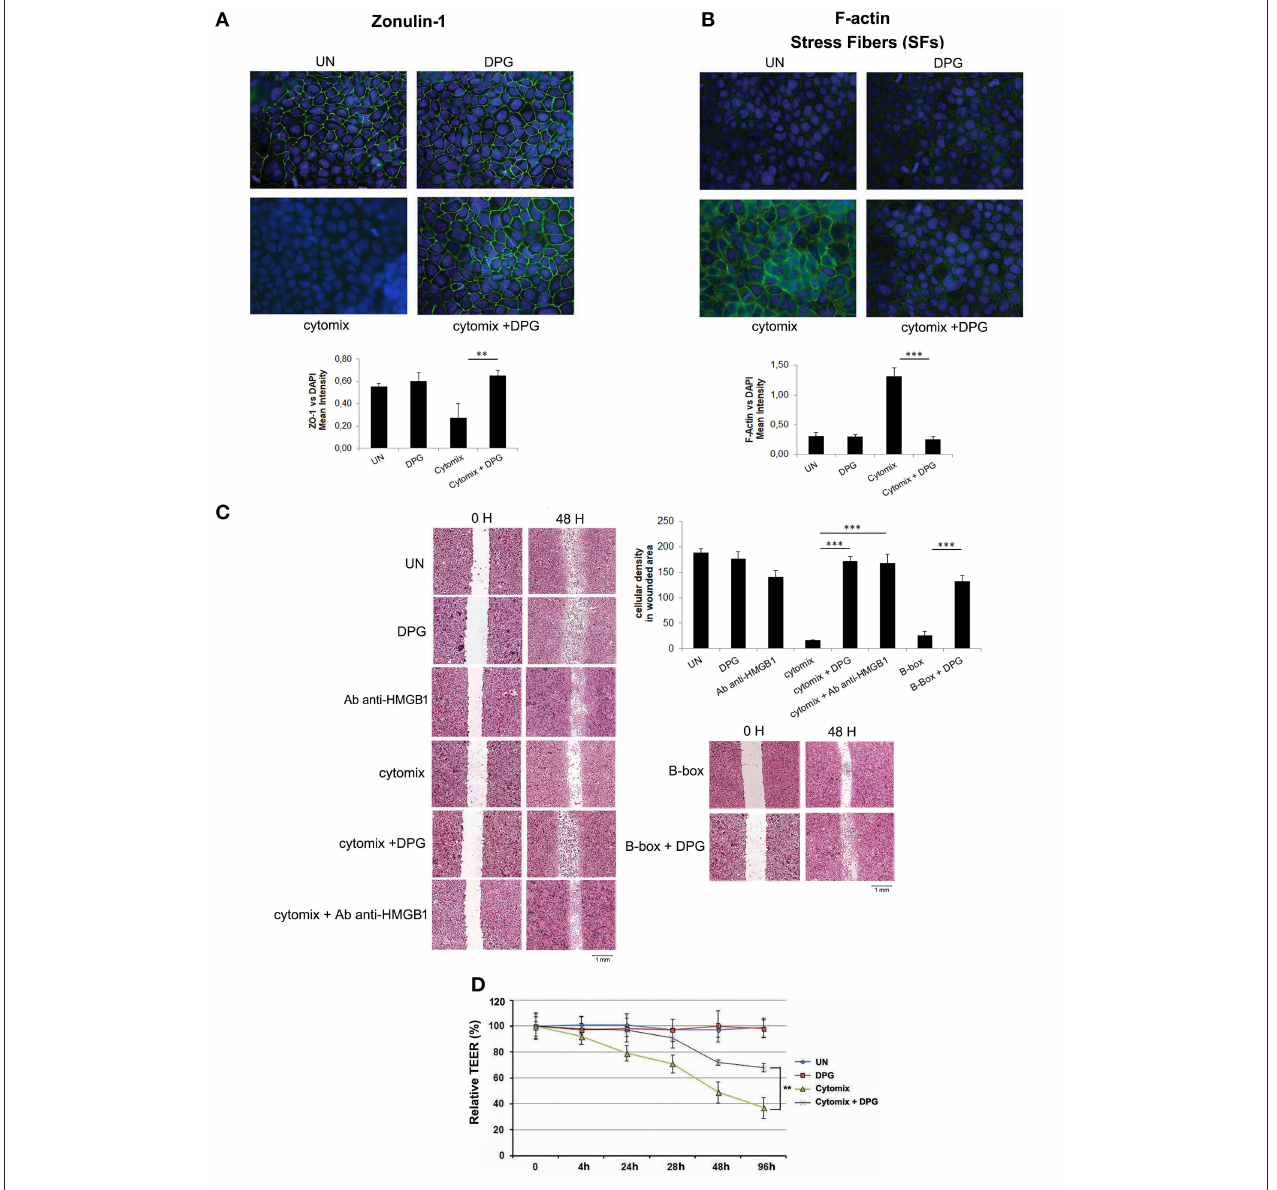
FIGURE 3 | DPG improves in vitro epithelial barrier functions and morphology. Zonulin-1 and F-actin expression and localization were determined by immunofluorescence in Caco2 treated with Cytomix, DPG and Cytomix + DPG Results are presented as Mean intensity of ZO-1 and F-actin fluorescence, relative to DAPI ± S.D, respectively. Magnification 20X (A,B) Scratch test and bar chart of cellular density of wounded area in HT29 (C) and TEER values (D) indicated wound healing in Caco2 cells treated with Cytomix, DPG, and Cytomix + DPG. The experiment was performed in triplicate and repeated 3 times. Statistical analysis: